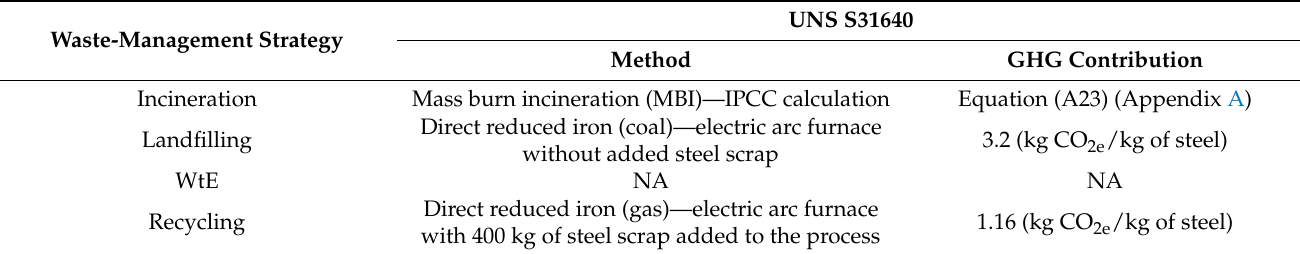
Table 34. Stainless steel waste-management technologies used [66,85,86].